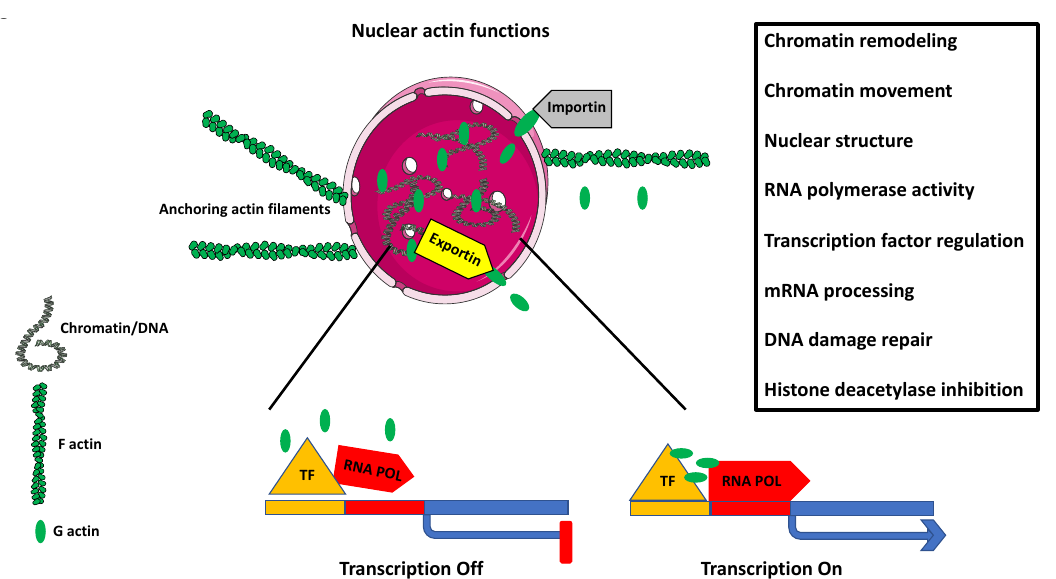
Figure 4. Nuclear actin. The diagram depicts some of the known functions of nuclear actin. The cell nucleus is anchored in q specific place within the cytoplasm by the cellular cytoskeleton containing actin filaments (F actin). The entry of the globular actin (G actin) to the nucleus is facilitated by the karyopherin protein Importin, and the exit is facilitated by the karyoprotein Exportin. Nuclear G actin plays a role in chromatin remodeling and chromatin movement. By regulating the activity of RNA polymerases I, II, III, and transcription factors, it regulates gene expression. It also participates in mRNA processing and DNA repair, and inhibits histone deacetylation. Additionally, nuclear matrix-associated actin plays a structural role in the overall nuclear organization.